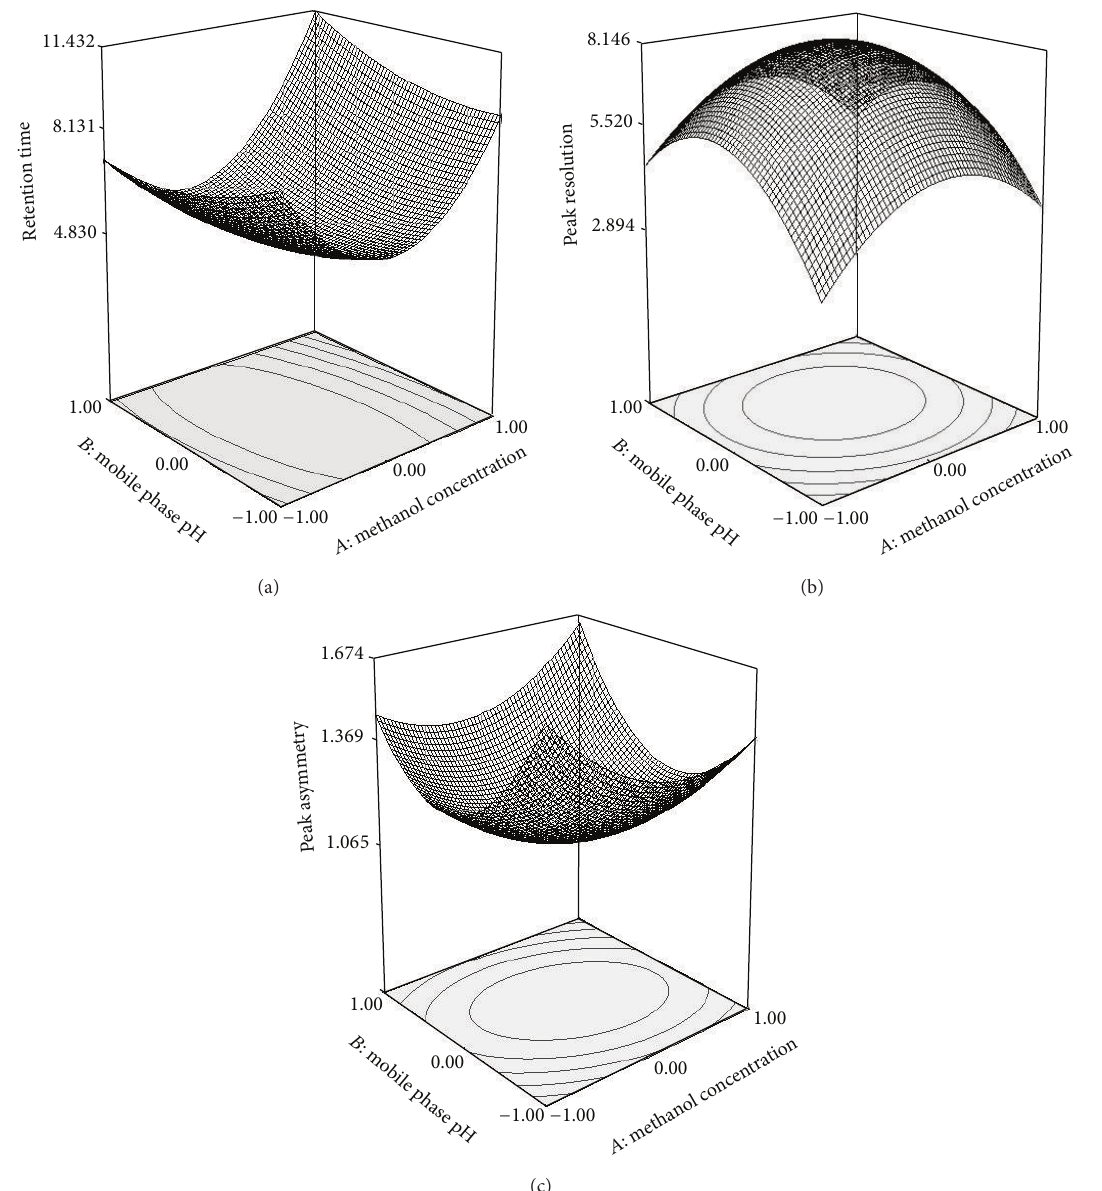
Figure 3: Three-dimensional graph showing (a) the effect of mobile phase and methanol concentration on retention time. (b) Three- dimensional graph showing the effect of mobile phase and methanol concentration on peak resolution. (c) Three-dimensional graph showing the effect of mobile phase and methanol concentration on peak